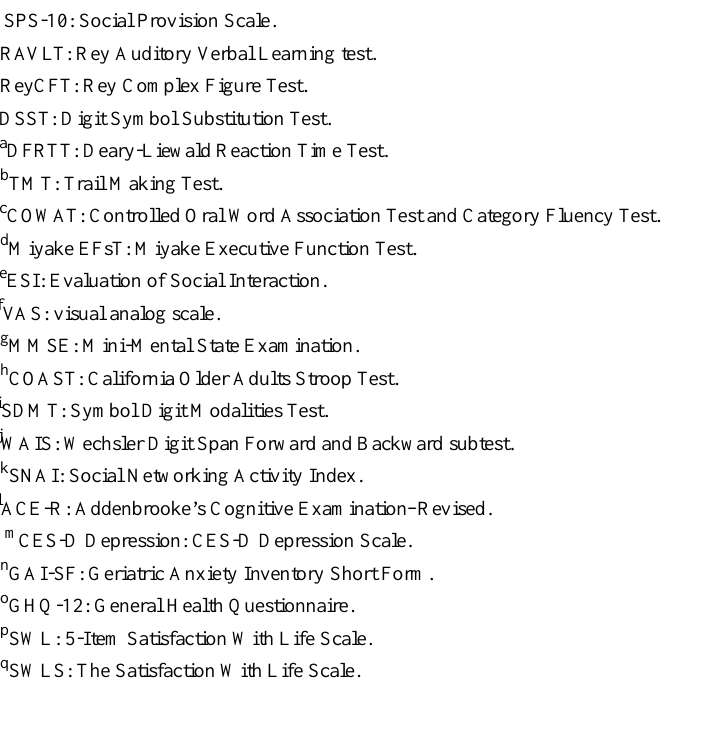
w SPS-10: Social Provision Scale. x RAVLT: Rey Auditory Verbal Learning test. y ReyCFT: Rey Complex Figure Test. z DSST: Digit Symbol Substitution Test. aa DFRTT: Deary-Liewald Reaction Time Test. bb TMT: Trail Making Test. cc COWAT: Controlled Oral Word Association Test and Category Fluency Test. dd Miyake EFsT: Miyake Executive Function Test. ee ESI: Evaluation of Social Interaction. ff VAS: visual analog scale. gg MMSE: Mini-Mental State Examination. hh COAST: California Older Adults Stroop Test. ii SDMT: Symbol Digit Modalities Test. jj WAIS: Wechsler Digit Span Forward and Backward subtest. kk SNAI: Social Networking Activity Index. ll ACE-R: Addenbrooke’s Cognitive Examination–Revised. mm CES-D Depression: CES-D Depression Scale. nn GAI-SF: Geriatric Anxiety Inventory Short Form. oo GHQ-12: General Health Questionnaire. pp SWL: 5-Item Satisfaction With Life Scale. qq SWLS: The Satisfaction With Life Scale.